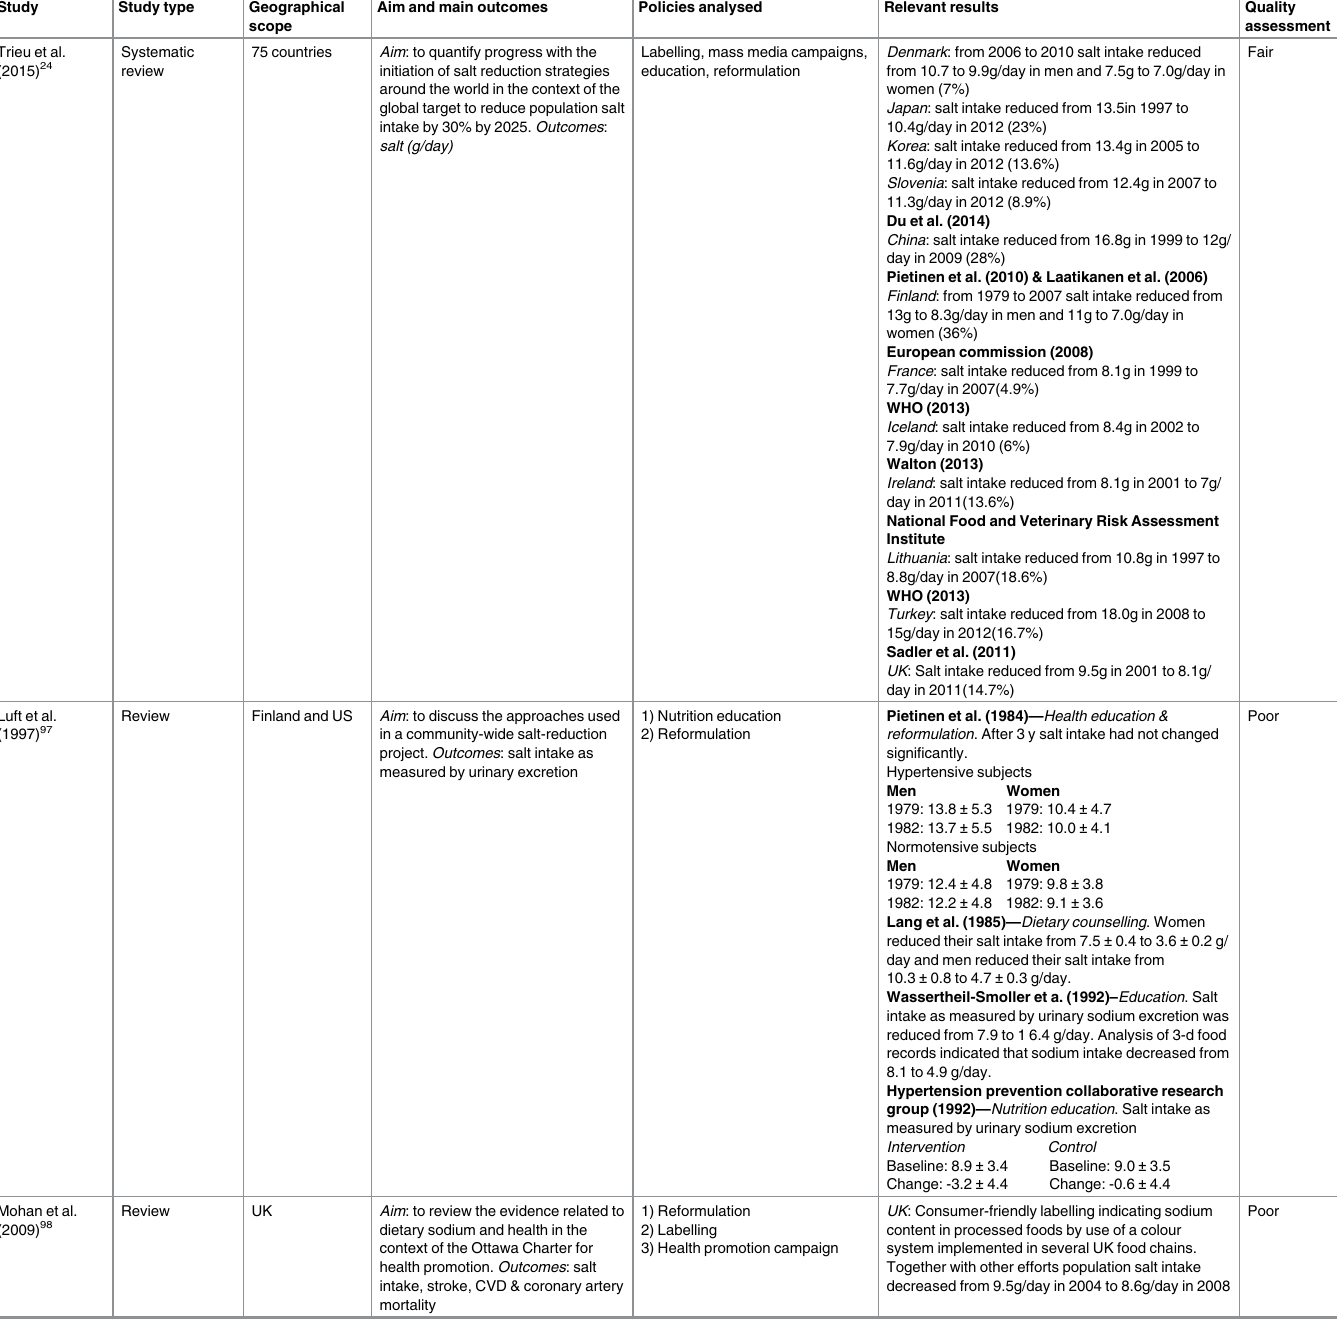
Aim :toreviewtheevidencerelatedto